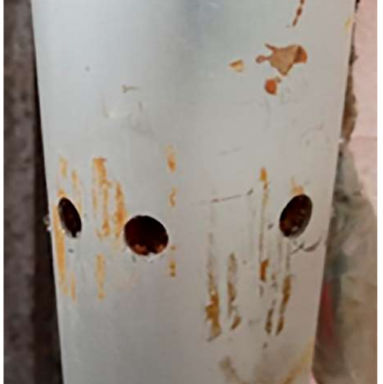
Figure 4. Holes drilled in